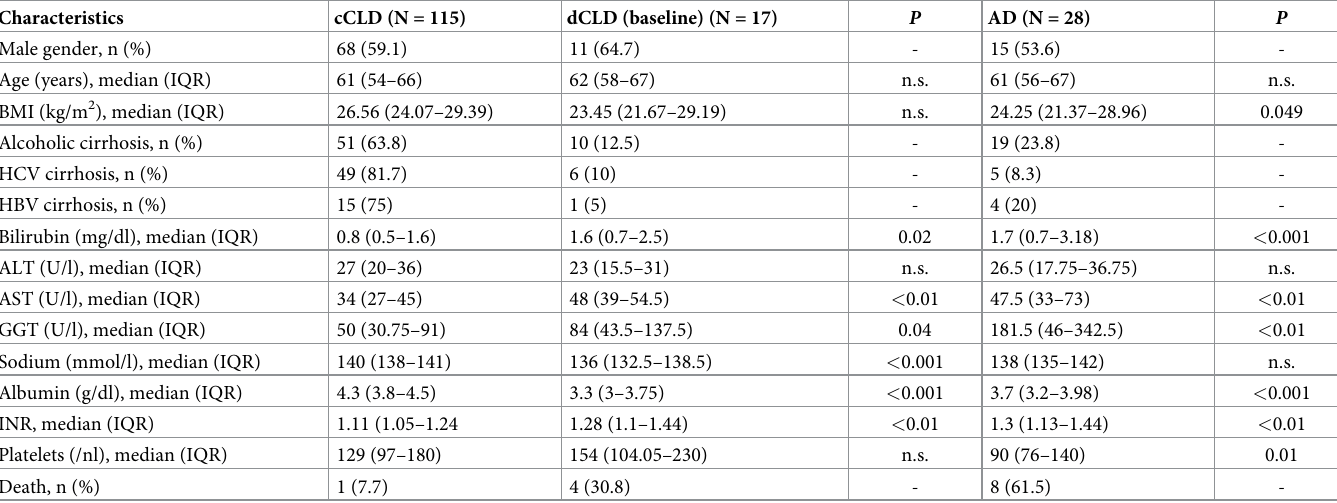
AD, acute decompensation; ALT, alanine aminotransferase; AST, aspartate aminotransferase; ARFI, acoustic radiation force imaging (m/sec); cCLD, compensated liver disease; dCLD, decompensated liver disease; GGT, gamma-glutamyl transferase; HBV, hepatitis B virus; HCV, hepatitis C virus, INR, international normalized ratio; IQR, interquartile range; n.s., not significant. p-values describe significance between cCLD vs. dCLD and cCDL vs. AD.